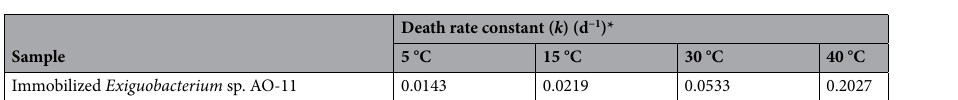
Figure 5. Percentages of immobilized Exiguobacterium sp. AO-11 cell survival after storage for 15 and 30 days with various protectants, including PB, trehalose, sucrose, PEG, PVP, and glycerol, at 4 °C and 30 °C under non- vacuum ( a , b ) and vacuum ( c , d ) conditions, respectively. Data correspond to the means of triplicate values, and error bars correspond to the standard deviation.